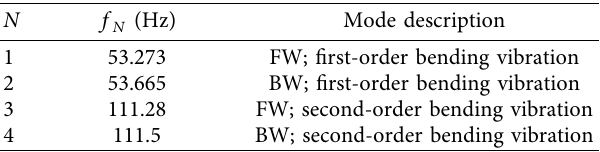
Figure 2: Optimized model of the flexible rotor shafting. Table 3: First four natural frequencies and modes of the flexible rotor shafting system.